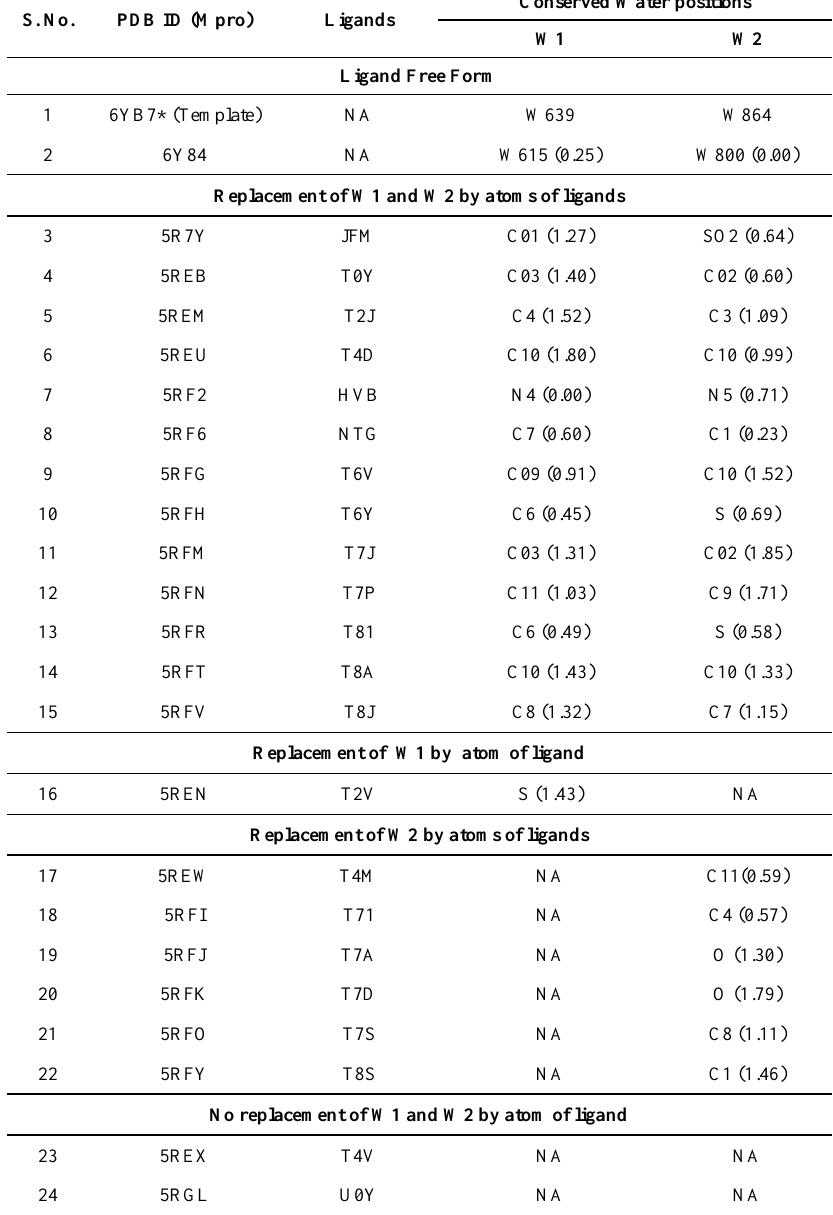
Table 2. A detailed list of x-ray crystal structures of Main protease and interactions (less than 1.80Å) between their ligands and conserved water IDs- W1 and W2 of PDB ID: 6YB7. S.